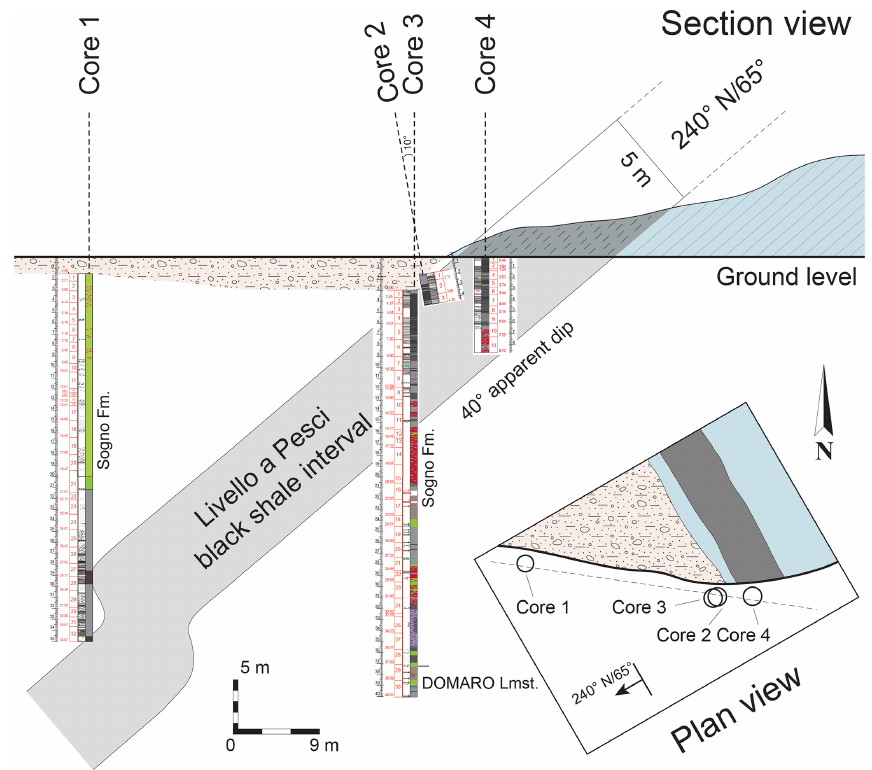
Figure 4. Section and plan view of the relative positions of the four boreholes drilled at Colle di Sogno. A pronounced fold was encountered at ∼ 25m penetration depth in Sogno borehole 1 that was abandoned after reaching the topmost part of the black shale interval. Three additional boreholes were cored as explained in the